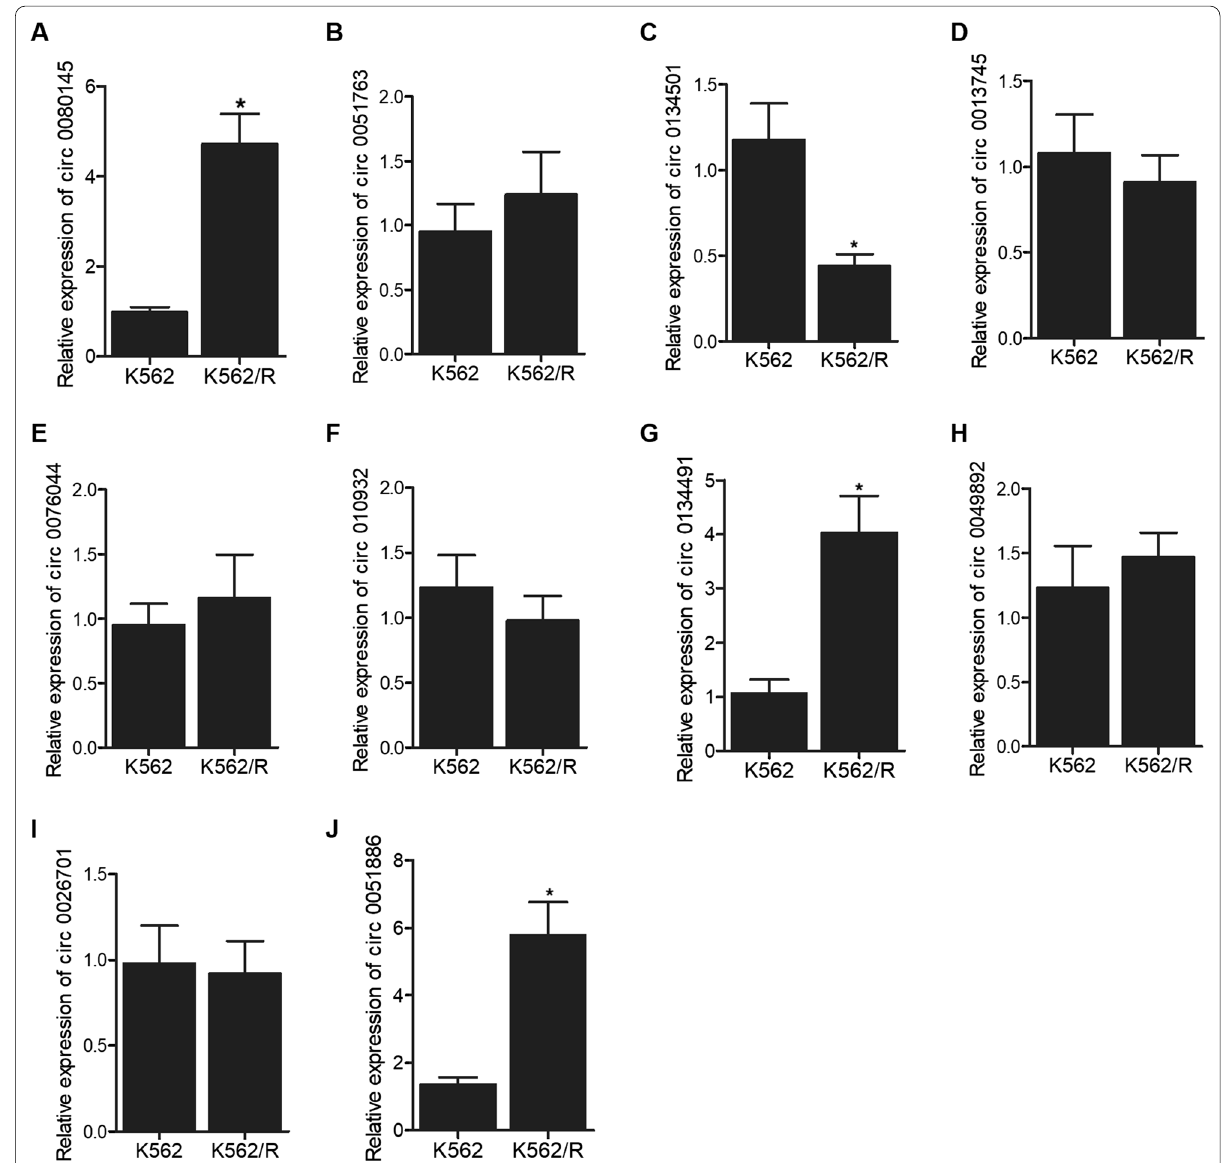
Fig. 2 The expression of candidate circRNAs in K562 cell groups indicated that circ_0080145, circ 0134501, circ 0134491 and circ_0051886 were dysregulated in K562/R cells (*P value < 0.05 vs. K562 group). A The relative expression level of circ_0080145 was higher in K562/R cells; B The relative expression levels of circ 0051763 were similar in K562 and K562/R cell groups; C The relative expression level of circ 0134501 was lower in K562/R cells; D The relative expression levels of circ 0013745 were similar in K562 and K562/R cell groups; E The relative expression levels of circ 0076044 were similar in K562 and K562/R cell groups; F The relative expression levels of circ 0109320 were similar in K562 and K562/R cell groups; G The relative expression levels of circ 0134491 were higher in K562/R cells; H The relative expression levels of circ 0049892 were similar in K562 and K562/R cell groups; I The relative expression levels of circ 0026701 were similar in K562 and K562/R cell groups; J The relative expression levels of circ_0051886 were higher in K562/R